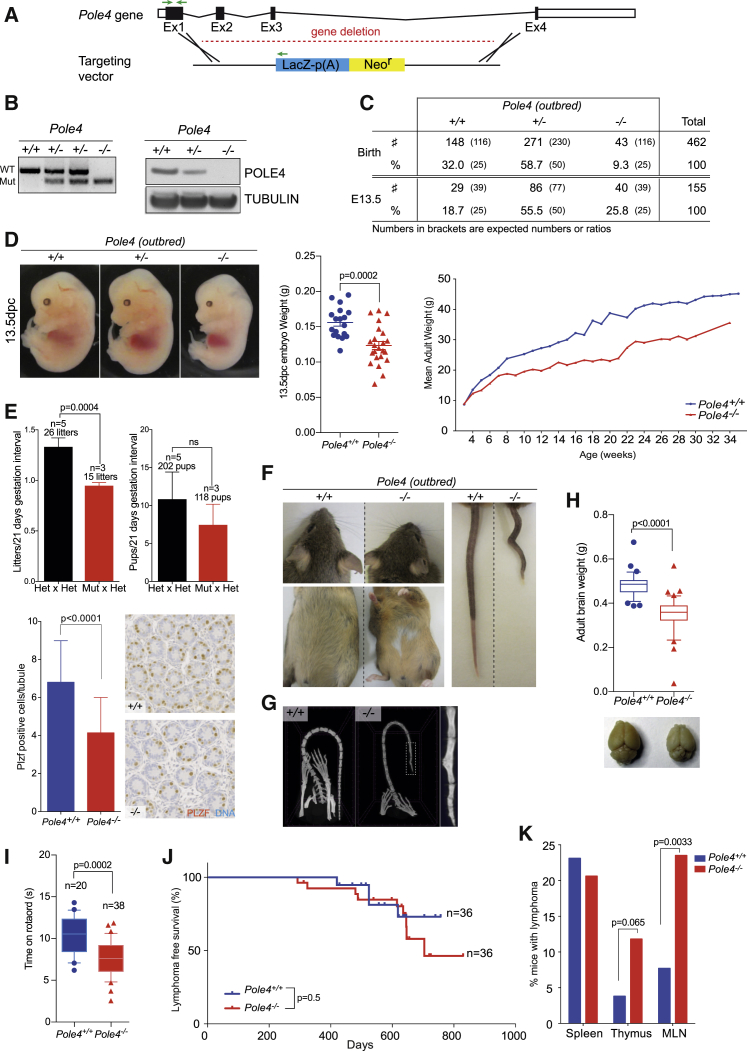
Pole4 Knockout Mice Are Viable in an Outbred Strain and Exhibit Phenotypes Similar to Human Patients with Mutations of POLE1 or POLE2(A) Schematic representation of the targeting vector used to generate the Pole4-deficient mice. The deletion cassette has been inserted 93 bp after the start of Pole4 exon 1 to replace the entire Pole4 gene. Green arrows represent primers used for genotyping.(B) Left: Pole4 genotyping strategy. Upper band represents the WT allele; lower band, the mutant allele. Right: western blot on 13.5 dpc Pole4+/+, Pole4+/−, Pole4−/− embryos illustrating loss of POLE4. Tubulin was used as loading control.(C) Breeding summary of Pole4+/− mice intercrosses at birth and during embryogenesis. Numbers and percentages in brackets are expected numbers and ratios. Pole4-deficient mice are represented at expected ratios at 13.5 dpc, whereas only 9.3% Pole4−/− mice are born.(D) Left: representative images of 13.5 dpc Pole4 embryos. Note the smaller size of Pole4−/− embryo. Scale bar, 1 mm. Middle: weight analysis of Pole4 embryos at 13.5 dpc. Error bars represent ± SEM of n = 18 Pole4+/+ and n = 23 Pole4−/−. Significance: t test, p = 0.0002. Right: weight analysis of Pole4+/+ and Pole4−/−mice. Error bars are not shown to render the graph readable; data are from males and females with at least five mice measured at each time point.(E) Top: breeding ability of Pole4 heterozygous × heterozygous versus mutant × heterozygous crosses. Each pair was bred during 5 months, and the number of litters and pups per litter was quantified per 21-day gestation. Significance: t test; litter per 21-day gestation, p = 0.0004; pups per 21-day gestation, p = 0.21. Bottom: testis tubules of 5-day-old neonates were stained with PLZF (germ cells; brown) marker. DNA was counterstained with hematoxylin (blue). Spermatogonia cell quantification per tubule. Error bars represent ± SEM of at least 50 tubules. Significance: t test, p < 0.0001.(F) Representative pictures of 5-month-old Pole4+/+ and Pole4−/− littermates illustrating craniofacial abnormalities, belly white patches, and kinks in the tail.(G) Micro-CT scan of tail from Pole4+/+ and Pole4−/− mice. Bar, 2.5 mm.(H) Brain-weight analysis of Pole4+/+ and Pole4−/− mice. Error bars represent ± SEM of n = 34 Pole4+/+ and n = 41 Pole4−/−. Significance: t test, p < 0.0001.(I) Rotarod experiment testing 3-month-old Pole4+/+ and Pole4−/− mice coordination. Note the decreased time spent on the rotating rod by Pole4−/− mice compared to their WT littermates. Error bars represent ± SEM of n = 20 Pole4+/+ and n = 38 Pole4−/−. Significance: t test, p = 0.0002.(J) Lymphoma-free survival of Pole4 mice. Significance: Mantel-Cox test, p = 0.5. n = 36 Pole4+/+ and n = 36 Pole4−/−. Mice culled due to nonspecific phenotypes (e.g., dermatitis, overgrown teeth, and fits) were excluded from this study.(K) Frequency of Pole4 mice with lymphomas in spleen, thymus, and mesenteric lymph nodes (MLNs). Significance: Fisher’s exact test, p = 0.86 for spleen, p = 0.0652 for thymus, and p = 0.0033 for MLNs.